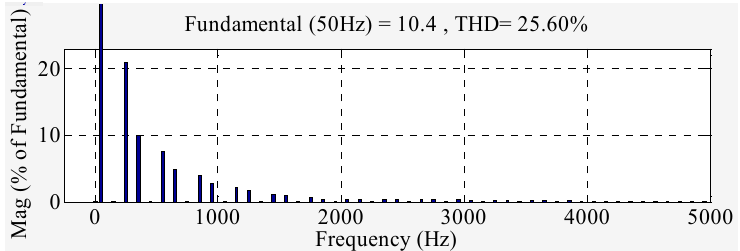
Figure 8. Source voltage v S and source current i S before compensation. Figure 8. Source voltage (cid:1874) (cid:3020) and source current (cid:1861) (cid:3020) before compensation. Figure 8. Source voltage (cid:1874) (cid:3020) and source current (cid:1861) (cid:3020) before compensation.